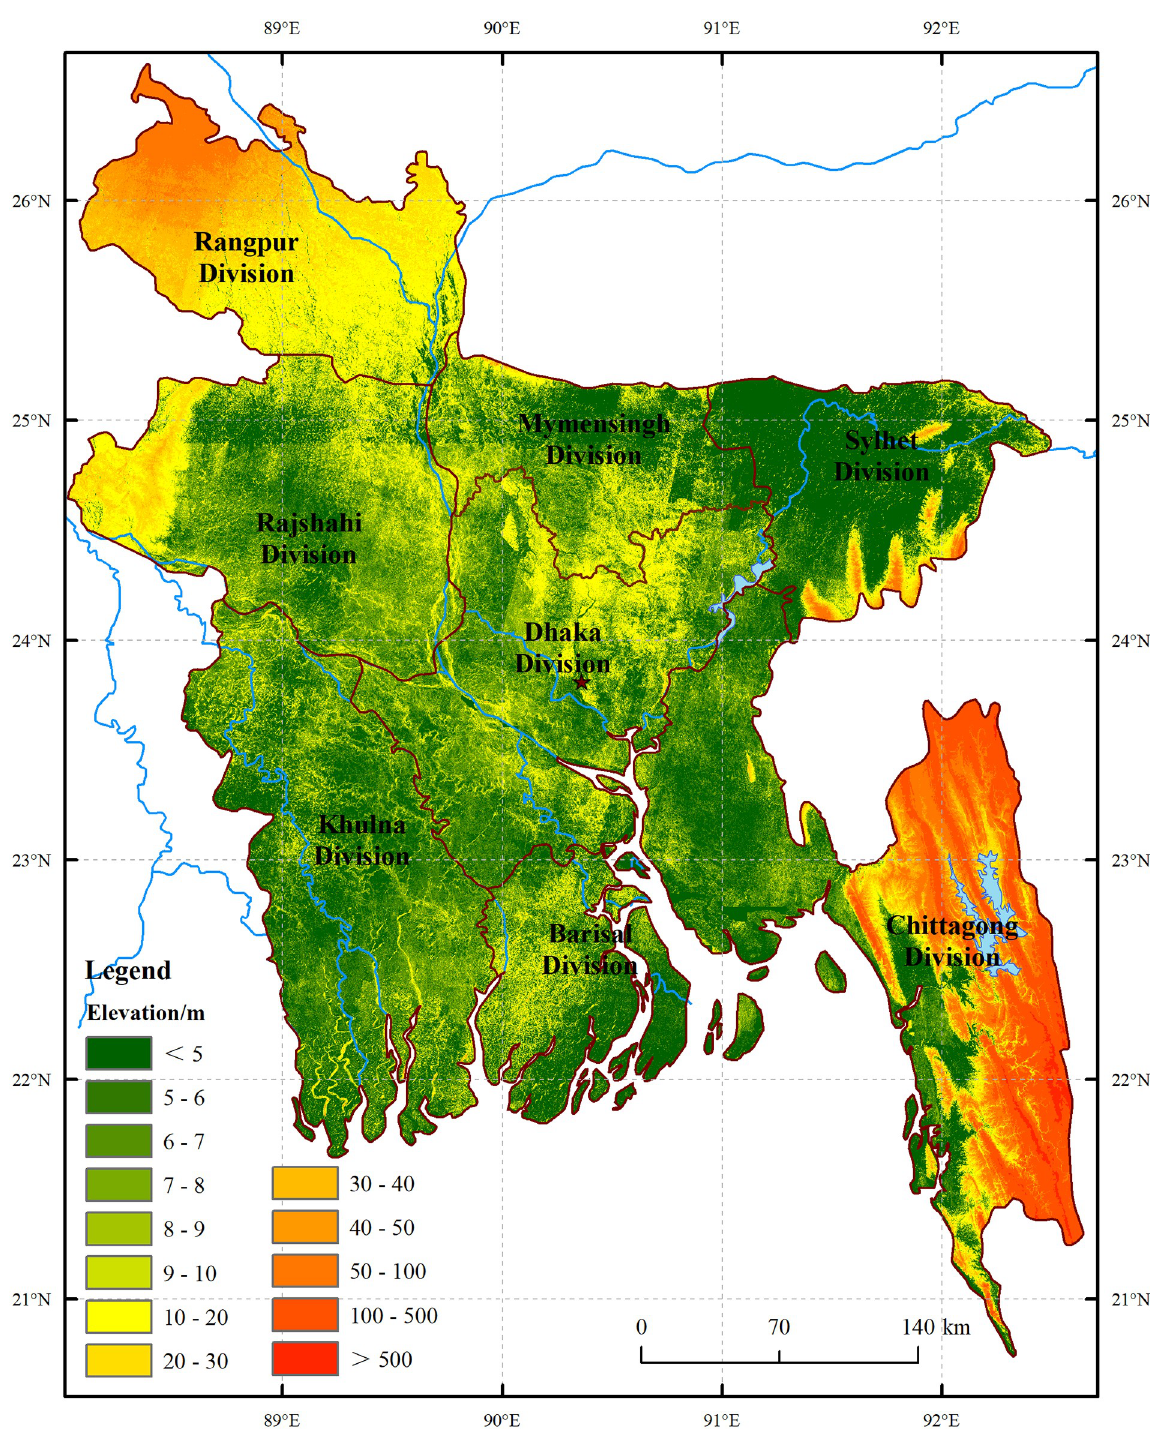
Fig 1. Location and digital elevation model of Bangladesh. The vector and elevation data used in this figure were obtained from Natural Earth (http://www.naturalearthdata.com) and Shuttle Radar Topography Mission (SRTM) dataset of United States Geological Survey (USGS) (http:// eros.usgs.gov/). The figure was similar but not identical to the original image and used for the description of elevation and position of Bangladesh.